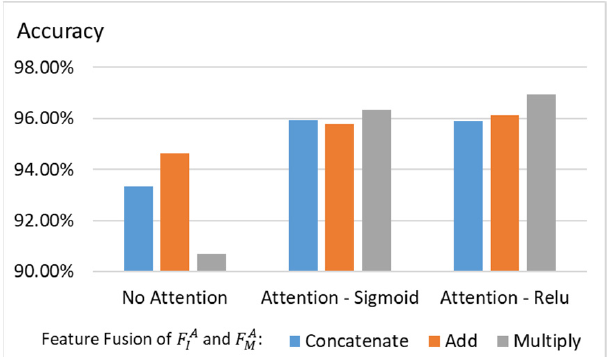
Figure 7. Experiments on attention module and feature fusion.